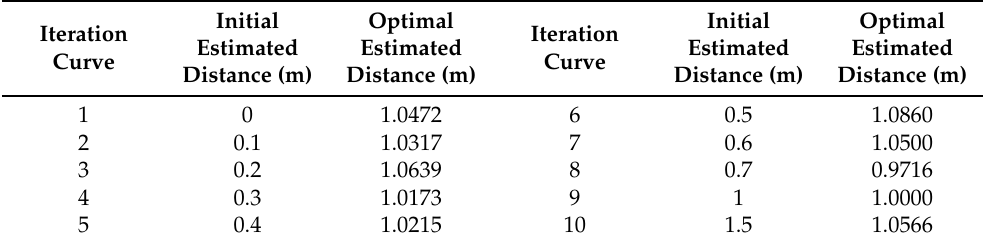
Table 2. The optimal estimated distance of near-field imaging results from different initial estimated distances of one-dimensional line array.